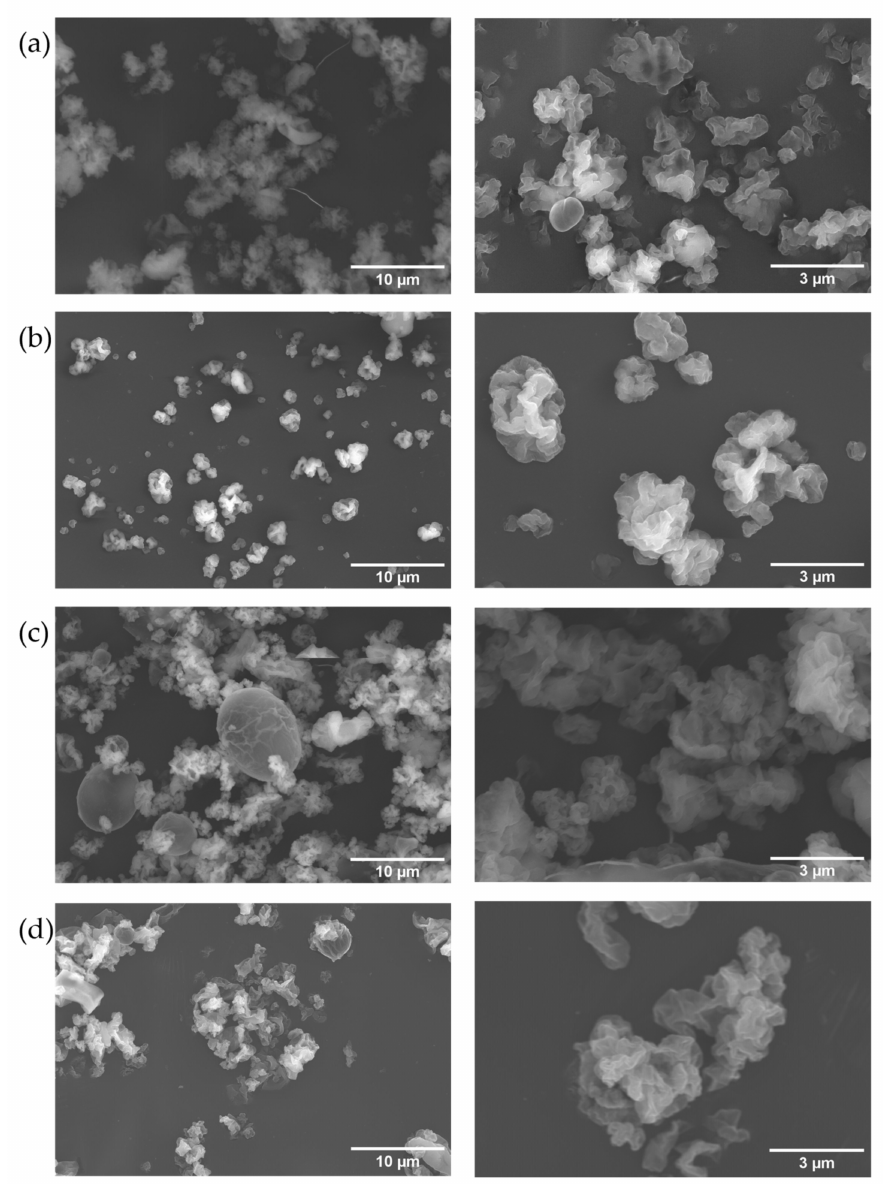
Figure 3. SEM micrographs of particles made with: ( a ) IPpEt75; ( b ) EPpEt50; ( c ) MW150 retentate; and ( d ) MW180 retentate. Images on the left have an ampliation of 3 k and on the right 10 k. Images on the left and on the right were collected with a 3000- and 10,000-times magnification,